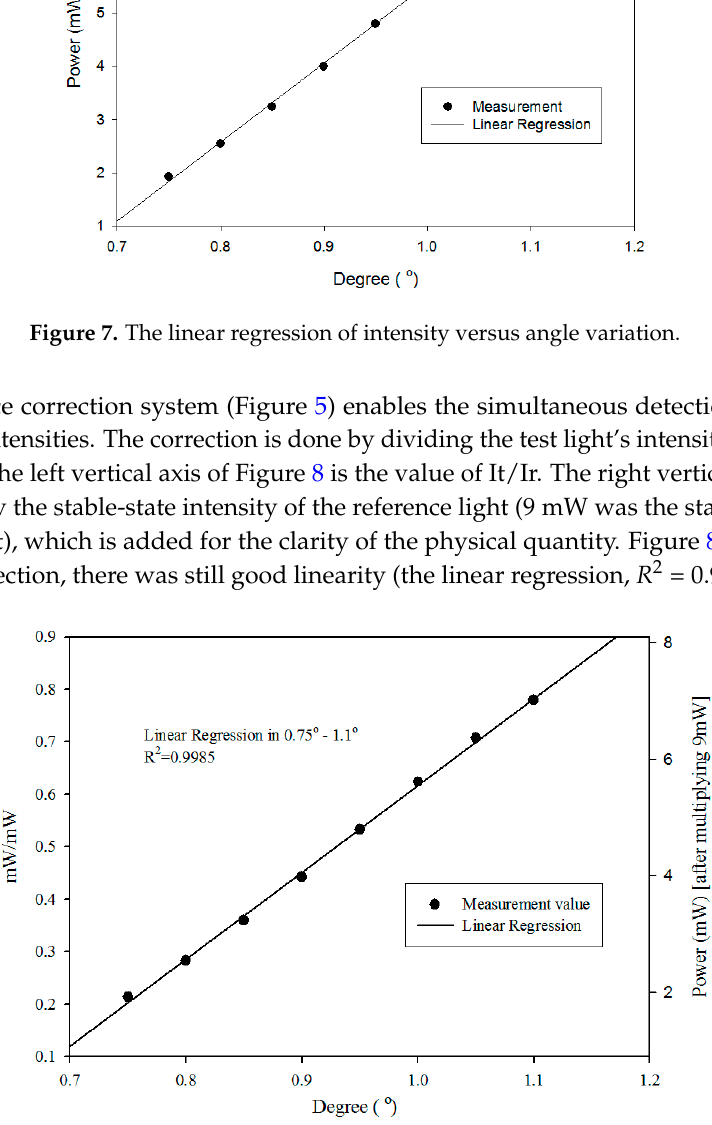
Figure 8. Test light intensity divided by the reference light intensity for determining the small-angle variation and plotted against the linear regression curve.